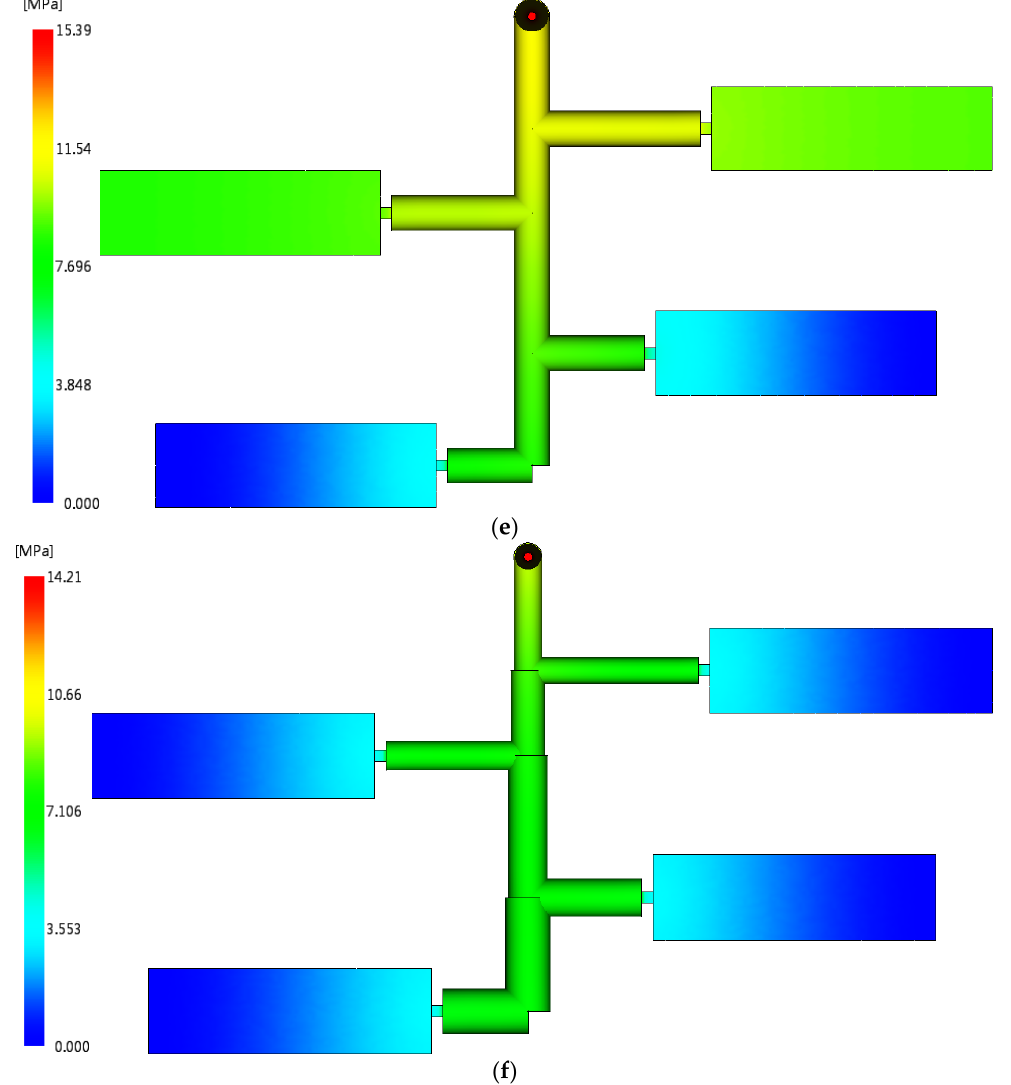
Figure 6. The comparison of an imbalanced and a balanced runner design of 8‑cavity mold (a half model): ( a ) 75% melt fill of an imbalanced runner system, ( b ) 100% fill of an imbalanced runner system, ( c ) 75% fill of a balanced runner system, ( d ) 100% fill of a balanced runner system, ( e ) injection pressure of an imbalanced runner design, and ( f ) injection pressure of a balanced runner design.